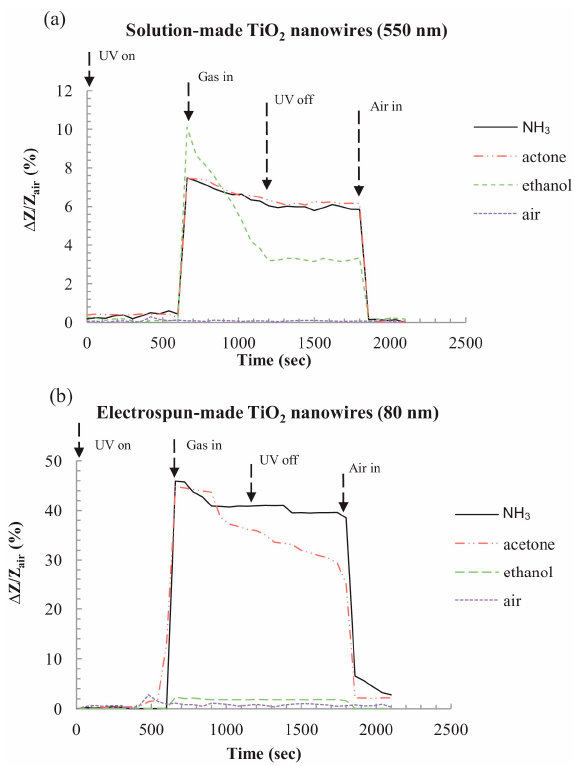
Figure 23. H 2 sensing of ZnO nanostructures in different atmospheres of synthetic air and nitrogen: ( a ) RT; ( b ) evaluated temperature of 200 °C; ( c ) RT and UV irradiation. NH 3 sensing of ZnO nanostructures in air and nitrogen: ( d ) RT; ( e ) 200 °C; ( f ) RT and UV irradiation. Reproduced with permission from [44].